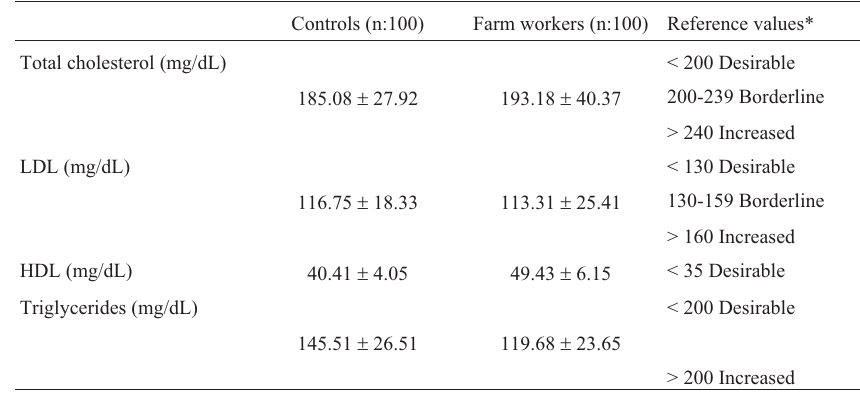
Table 4 - Lipid profile of study groups (mean +